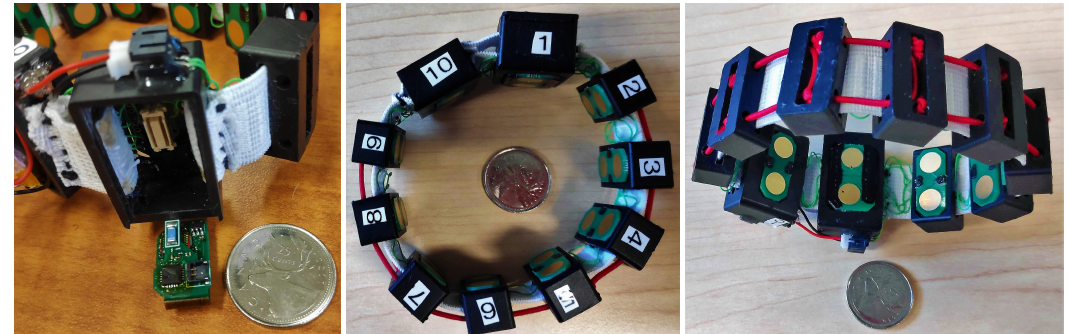
Figure 1. The proposed 3DC Armband. The system and the battery are held in the receptacles identified by 1 and 10 respectively. The label on each part of the armband corresponds to the channels’ order that are recorded for the dataset described in Section